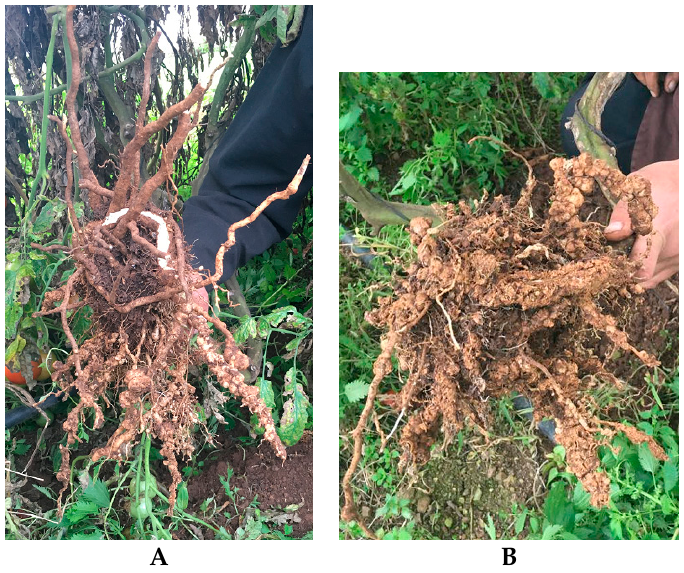
Figure 6. ( A ): Root of whey-treated tomato plant at the end of the culturing season, ( B ): Untreated control tomato root.